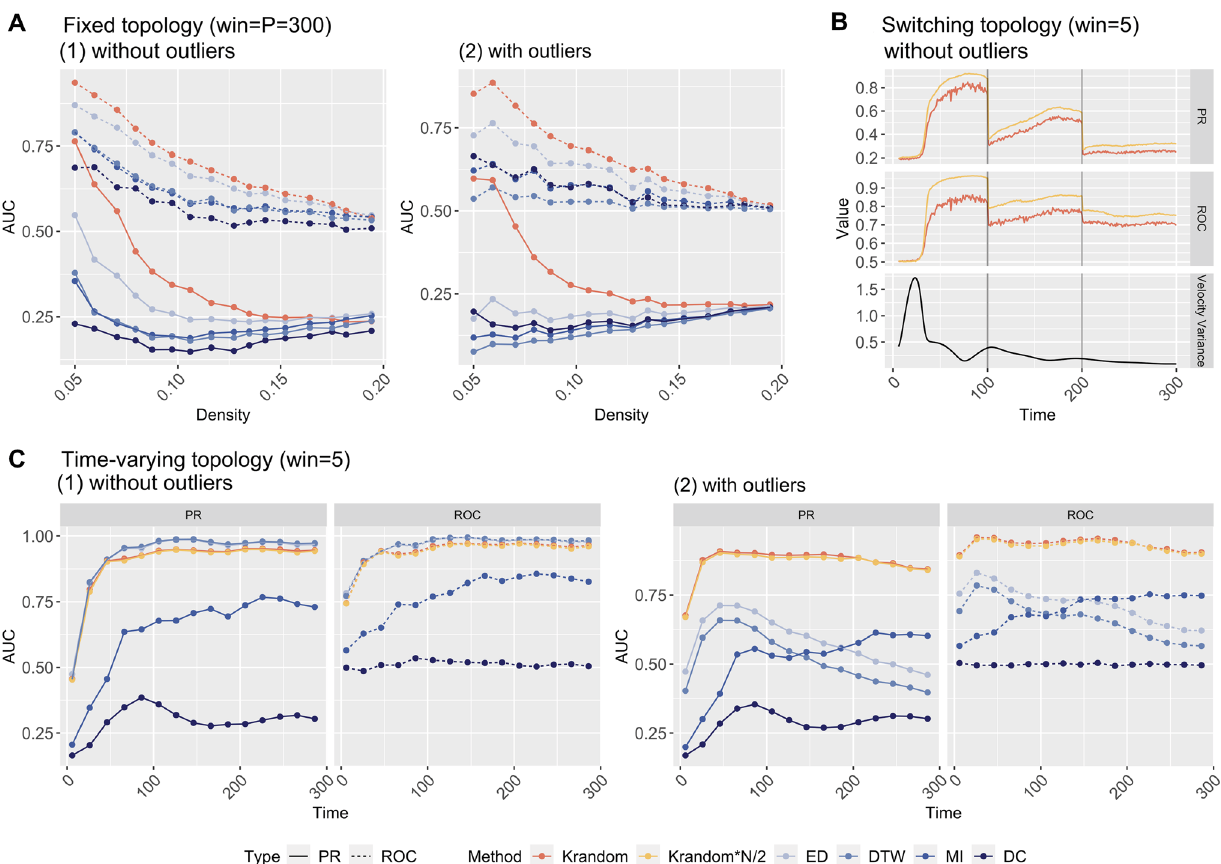
Fig. 5 Comparison of methods in fixed, switching, and time-varying topology. A Comparison with four benchmark methods in fixed topology, B online inference in switching topology, C comparison with four benchmark methods in fixed